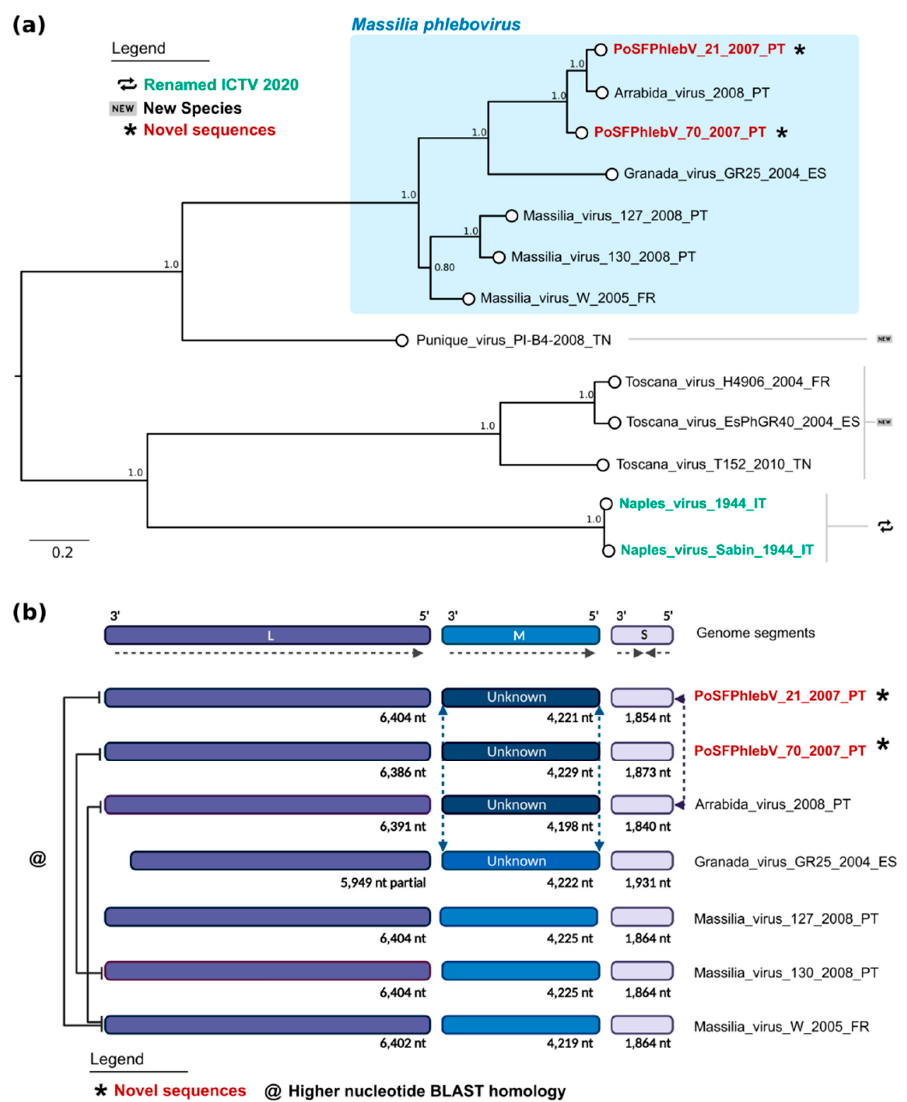
Figure 3. Maximum likelihood phylogenetic tree of phleboviruses’ full nucleotide concatenated segments and recombination results. ( a ) Phylogenetic tree. Sequence names in red and marked with an asterisk have been sequenced in this study. According to the International Committee on Taxonomy of Viruses 2020, sequence names in green have recently had their species renamed, while those marked by “new” symbols on the right side of the tree have been assigned as new species. Names of the sequences in the tree match the IDs in the alignment made available as a supplementary File S2: Phleboviruses’ nucleotide concatenated sequence alignment of all segments. Numbers on branches are the bootstrap support. The shaded area on the top shows the classic Massilia phlebovirus group. ( b ) Schematic of genome data and recombination results from RDP (created with https://biorender.com/). The full lines on the left link the genomes with highest nucleotide homology in the segment L sequence.